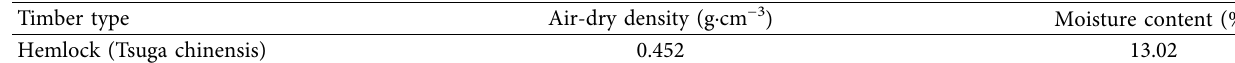
Table 4: Physical properties of wood.